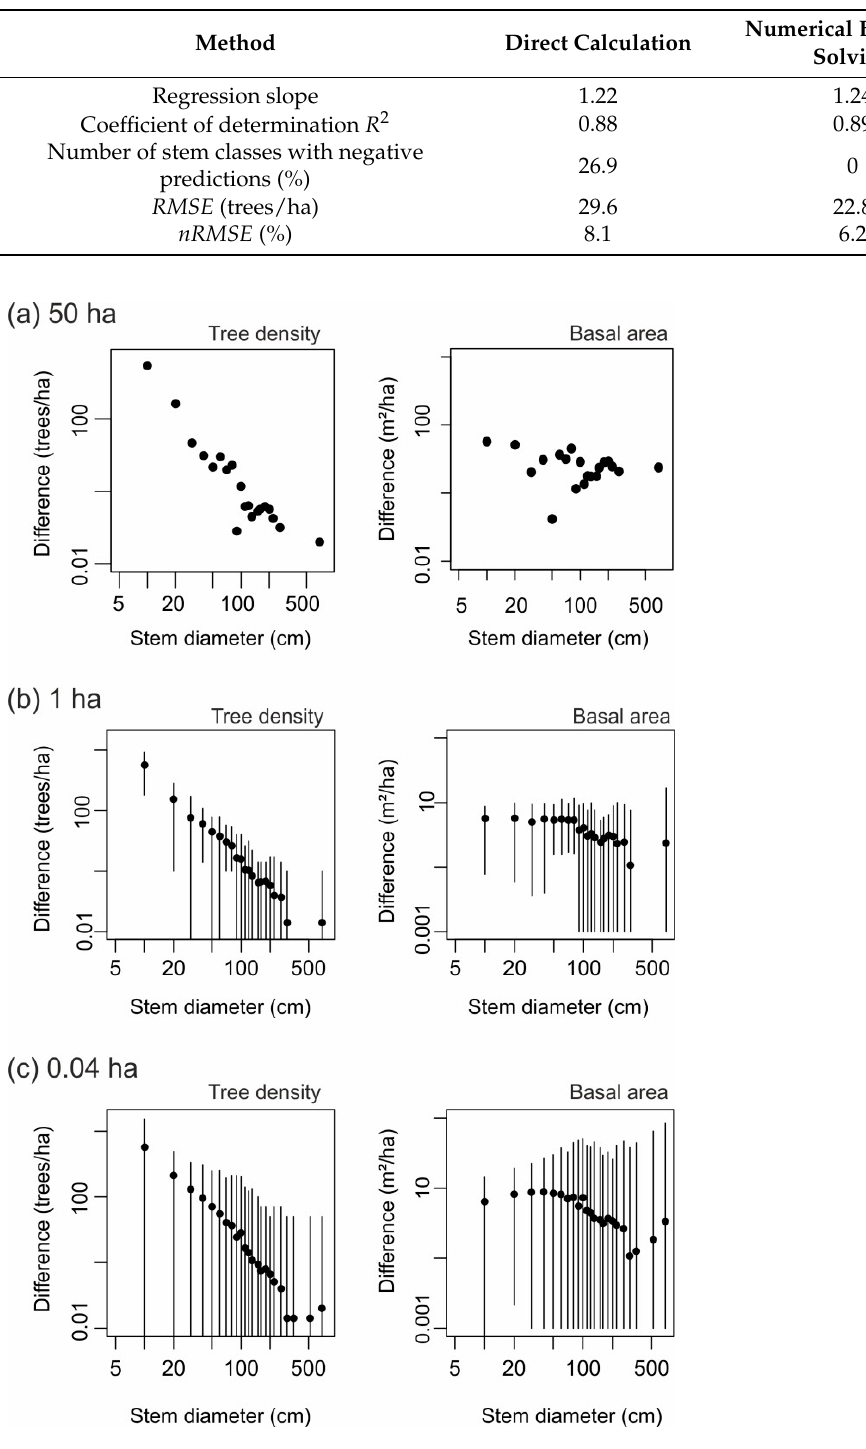
Figure A3. Evaluation of uncertainties in the lidar-derived tree density (in trees per ha) and lidar- derived basal area (in m²/ha) for three spatial scales: ( a ) 50 ha, ( b ) 1 ha, and ( c ) 0.04 ha. Uncertainties are calculated as the absolute difference of stem numbers or basal area (logarithmic y -axes) per stem diameter class ( x -axes) between the results from lidar and field data (points show the mean and the solid line shows the range from minimum to maximum). Note that zero differences are not